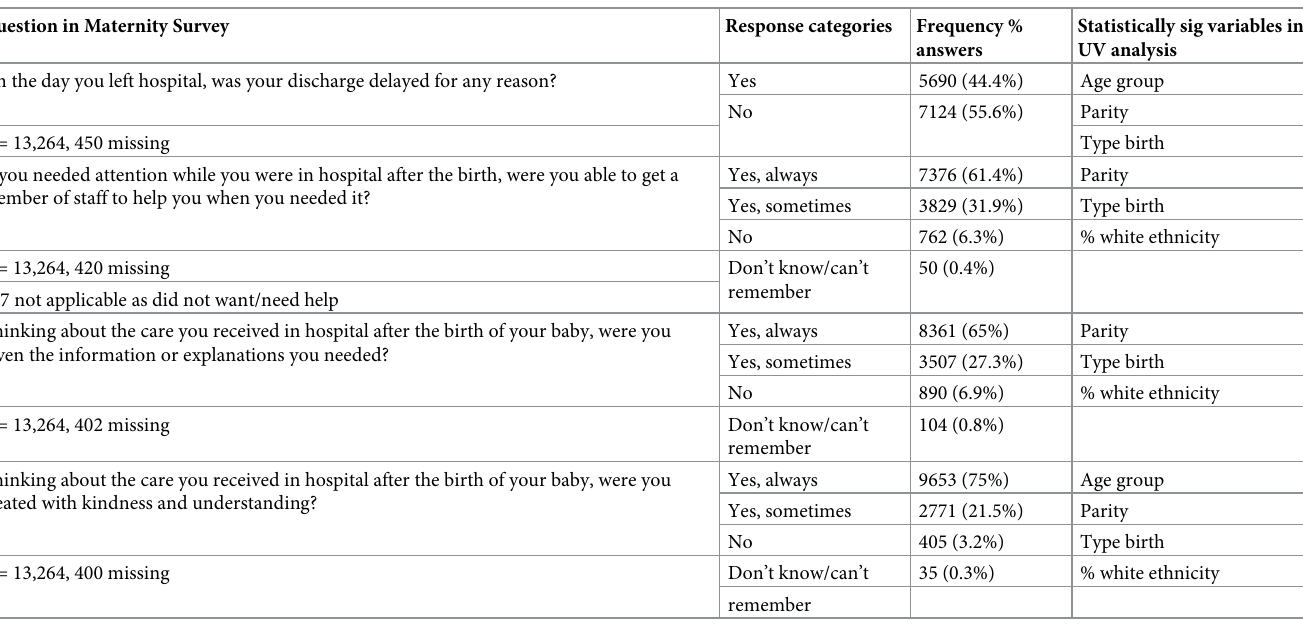
Table 4. Summary of postnatal experience